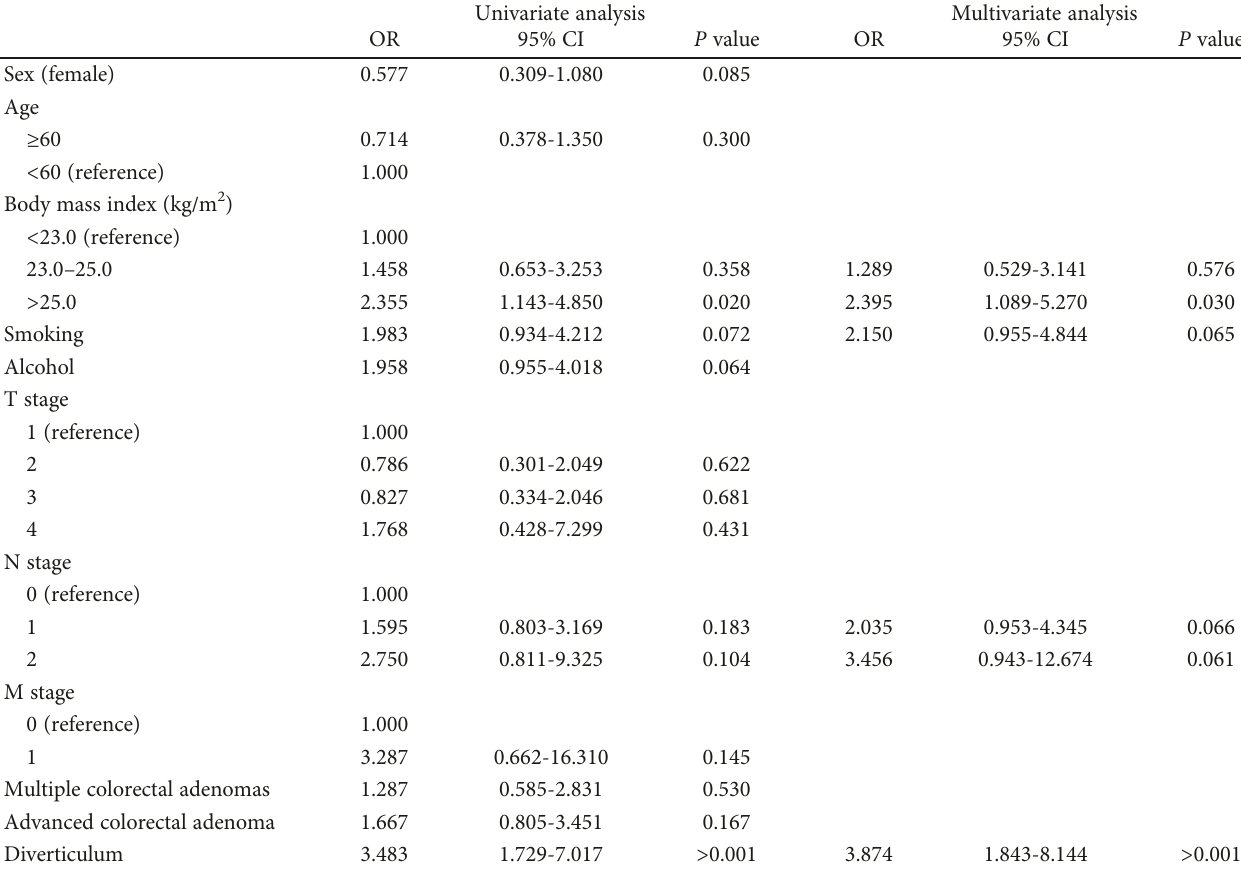
Table 3: Univariate and multivariate analyses for risk of synchronous colorectal adenoma ( n = 168